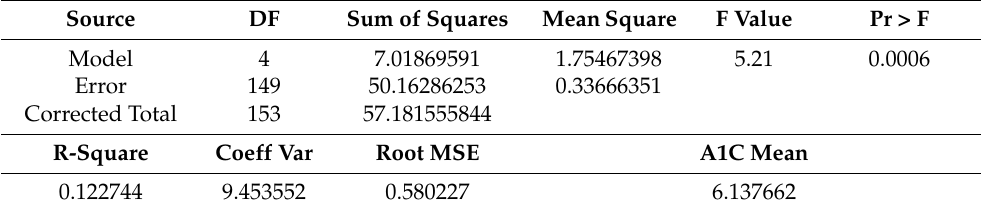
Table A5. GLM with A1C < 7% as dependent variable.